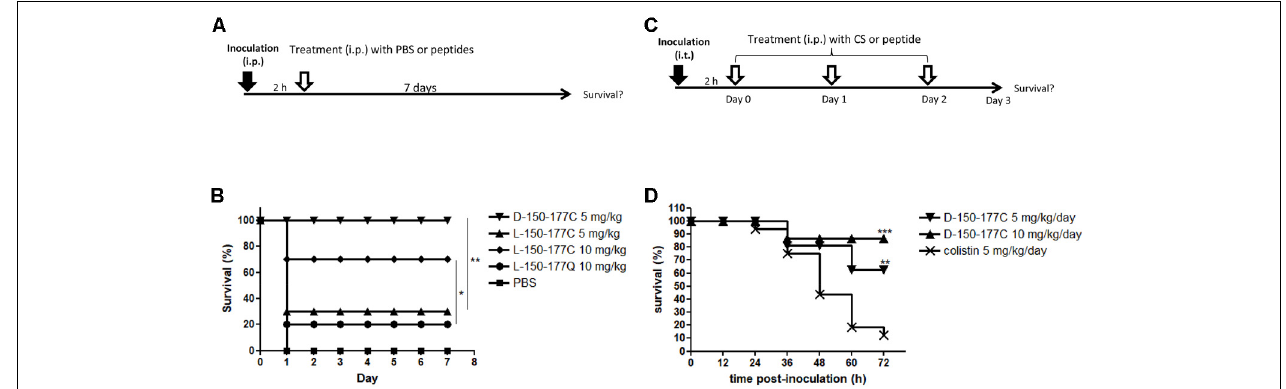
FIGURE 2 | Comparisons of in vivo protection efficacy of HBcARD derivatives in two animal models. (A) In a mouse sepsis model, ICR mice ( n = 10/group) were i.p. inoculated with S. aureus ATCC19636 (4 ∗ 10 6 /mouse) before treatments at 2 h post-inoculation. The survival rates were monitored for 7 days after injection. (B) All PBS control mice died at day 1, and only 20% of mice treated with a peptide L-150-177Q survived. Administration of L-150-177C peptide at the dose of 5 and 10 mg/kg can rescue 30 and 70% of mice from death, respectively. When treated with 5 mg/kg of D-150-177C, all mice survived. (C) In a lung infection mouse model, 6–8-week-old male C57BL/6JNarl mice were anesthetized by Isoflurane via inhalation, before intra-tracheal (i.t.) inoculation with A. baumannii (3.5 × 10 8 CFU/mouse). Two hours after inoculation, mice were intraperitoneally (i.p.) injected daily with either colistin (CS) or HBcARD peptides for three consecutive days. The survival rates were monitored for 3 days after infection. (D) C57BL/6JNarl mice (16 mice/group) were i.t. inoculated with A. baumannii TCGH46709 (colistin-resistant strain) before treatment with either colistin (5 mg/kg) or D-150-177C peptide (5 and 10 mg/kg). There was a dose-dependent effect on the survival rate of mice receiving D-150-177C. The survival rates of mice treated with D-150-177C were significantly higher than that with colistin treatment. This result indicated that D-150-177C was more potent than colistin for killing colistin-resistant A. baumannii . ∗ P < 0.05; ∗∗ P < 0.01; ∗∗∗ P <